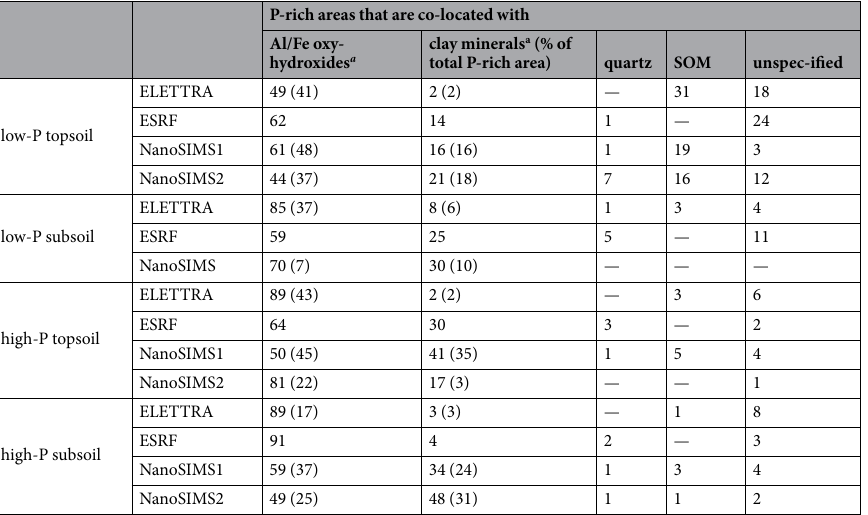
Table 1. Phosphorus (P)-rich areas that are co-located with aluminium and iron (Al/Fe) oxyhydroxides, clay minerals, quartz, and soil organic matter (SOM). a Brackets: share of compound that is also co-located with SOM. Nanoscale Secondary Ion Mass Spectrometry (NanoSIMS) and synchrotron-based X-Ray Fluorescence ( μ -XRF) mapping (at the synchrotrons ELETTRA, Italy, and ESRF, France) were used. In three aggregates, μ -XRF imaging included two NanoSIMS measurements (displayed as subscript 1 and